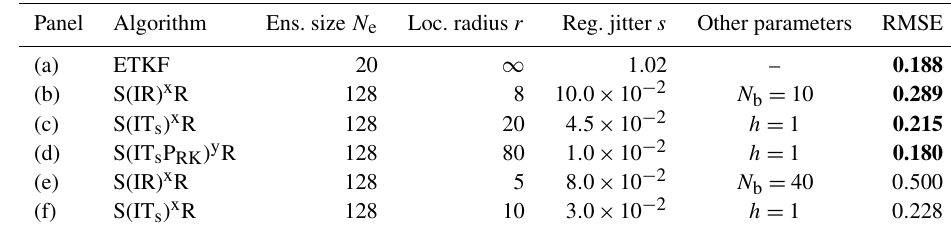
Table D1. Rank histograms computed with the L96 model in the standard configuration (see Appendix D). All LPFs use zero integration jitter ( q = 0). The localisation radii are given in number of grid points. For the ETKF, the optimal multiplicative inflation is reported in the regularisation jitter column. The bold font in the RMSE column indicates that the algorithm parameters have been tuned to yield the lowest RMSE score. The first column indicates the corresponding panel in Fig. D1.